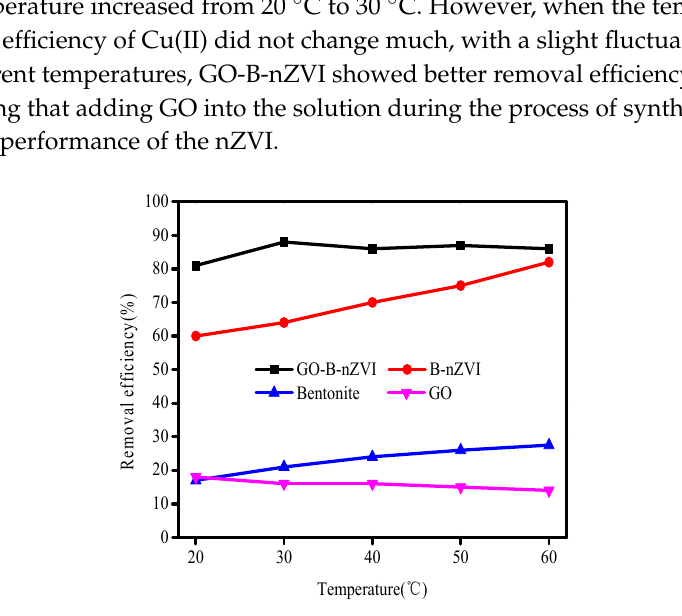
Figure 9. Removal efficiency of Cu(II) by bentonite, GO, B-nZVI, and GO-B-nZVI with time (Adsorbent dose = 1 g·L − 1 ; pH = 5 ± 0.3; concentration of Cu(II) = 80 mg·L − 1 ; adsorption time = 4 h).